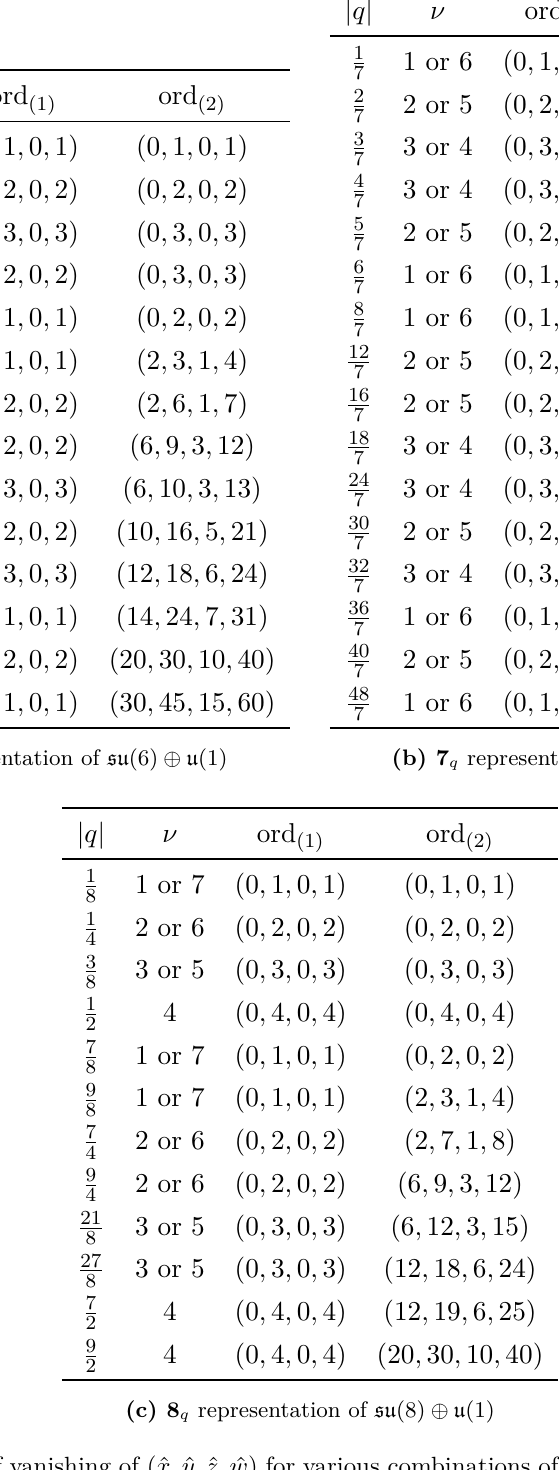
Table 11. Orders of vanishing of (ˆ x, ˆ y, ˆ z, ˆ w ) for various combinations of ν and pseudo-charge q for fundamental matter of su ( n ) ⊕ u (1) with 6 ≤ n ≤ 8 . The su (7) ⊕ u (1) data are found using the model in eq. (7.3), and the su (6) ⊕ u (1) and su (8) ⊕ u (1) data are found using the seed model for fundamentals with even n